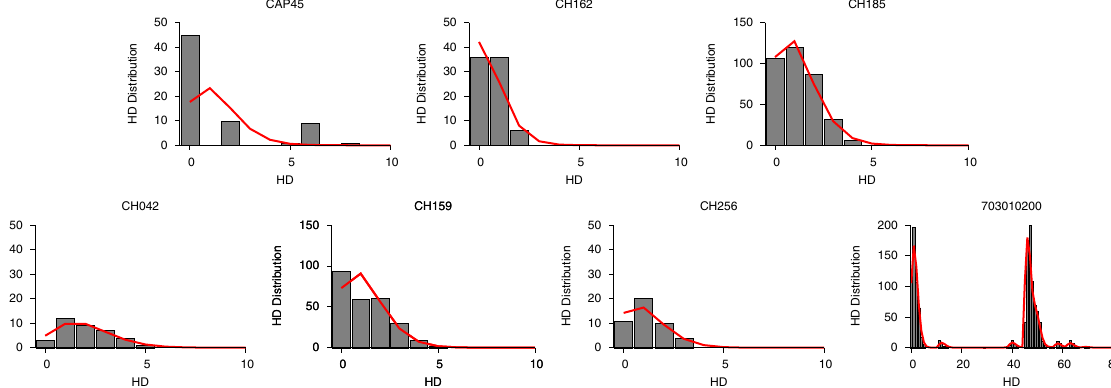
Figure 4. The intersequence Hamming distance (HD) distribution (grey bars) of HIV-1 full envelope gene sequences obtained from each subject in the slow (CAP45, CH162, and CH185) and fast GSI dynamics groups (CH042, CH159, CH256, and 703010200) along with the best fit (red curve) of the Shifted Poisson Mixture Model (SPMM) 22 . The SPMM estimated a single founder variant for all subjects except subject 703010200, whose infection was estimated to originate from six founders (when two putative recombinant strains from subject 703010200 were excluded, the number of founders was estimated to be 4. Here the minimum distance between founder variants was set as 10). The infection duration estimated by SPMM for subject CAP45, CH162, CH185 in the slow group was 24.1 [12.2–35.9] (goodness of fit p < 0.0001), 11.0 [3.4–18.6] (p = 0.07) and 21.4 [13.9–28.8] (p = 0.49) days and for subject CH042, CH159, CH256, and 703010200 in the fast group was 35.7 [19.2–52.2] (p = 0.90), 22.8 [14.4–31.1] (p = 0.002), 21.0 [8.9–33.1] (p = 0.66) and 28.4 [22.2–34.5] (p < 0.0001) days, respectively. The SPMM fits’ sum of squared errors (SSE) and Akaike information criteria (AIC) were 0.33 (291.0), 0.024 (152.9), 0.0017 (966.7), 0.0078 (118.7), 0.022 (761.0), 0.011 (119.2), and 0.0055 (4098.1) for